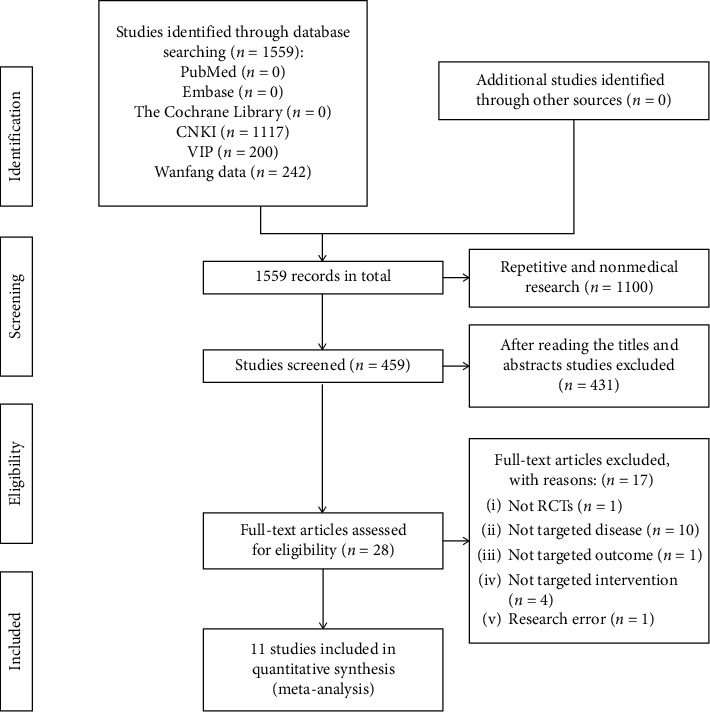
Flow chart of study selection.